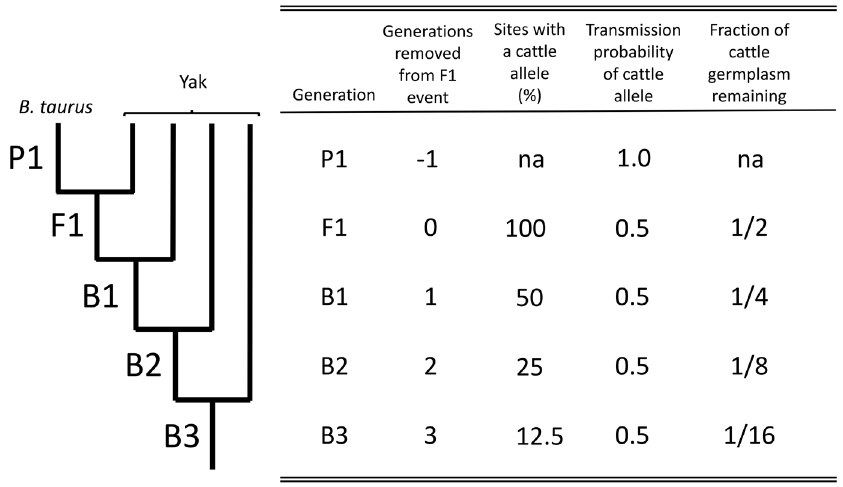
Figure 3. Detecting cattle alleles from an F1 hybridization event followed by yak backcrossing. Abbreviations: P1, parental generation; F1, hybrid generation; B, backcross generations; na, not applicable.